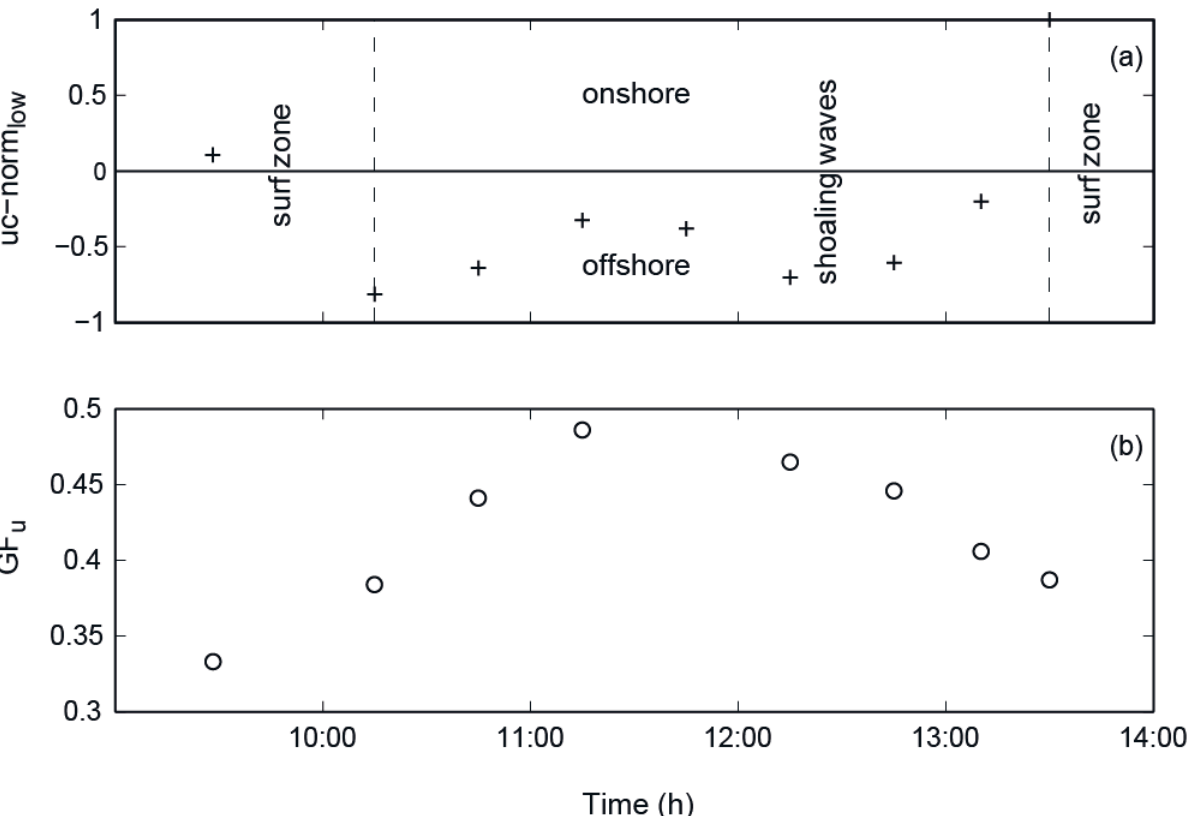
Figure 10. Variation of ( a ) normalised net suspended sediment flux (+) due to infragravity frequency waves; ( b ) wave groupiness factor (o) with time; Cable Beach, Broome, Western